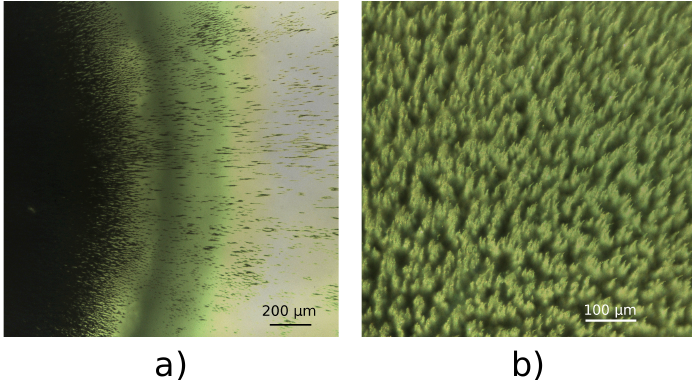
Figure 4. ( a ) Microscopic image at the beginning of the aggregation procedure at the end of the aggregate, next to the bottom wall. The contour of the cylindrical magnet is also visible. Most of the MNPs aggregated into a chain-shaped forms, which were nearly parallel to the magnetic field. The fluid flowed from the left to the right. ( b ) A magnified dark-field image from the top of the steady-state aggregate close to its horizontal center. The ends of the individual aggregate groups are in focus. The fluid flowed from the left to right, which caused the bent shape of the aggregate